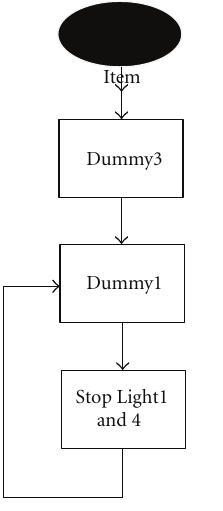
Figure 4: Tra ffi c intersection submodel.